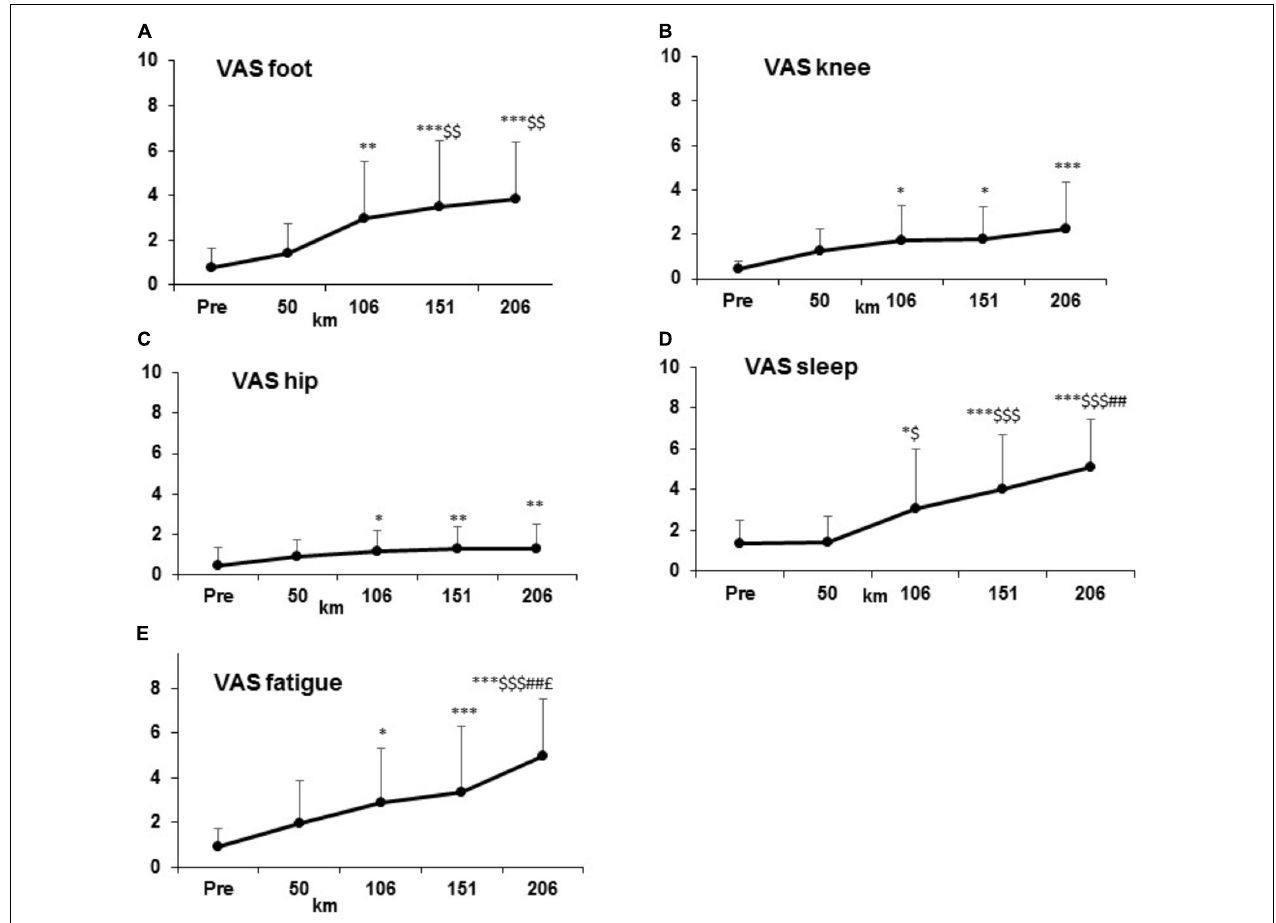
FIGURE 3 | Increase of Visual Analogic Scale (VAS) parameters: subjective pain values (A–C) , general feeling (D–E) at condition PRE and every 50